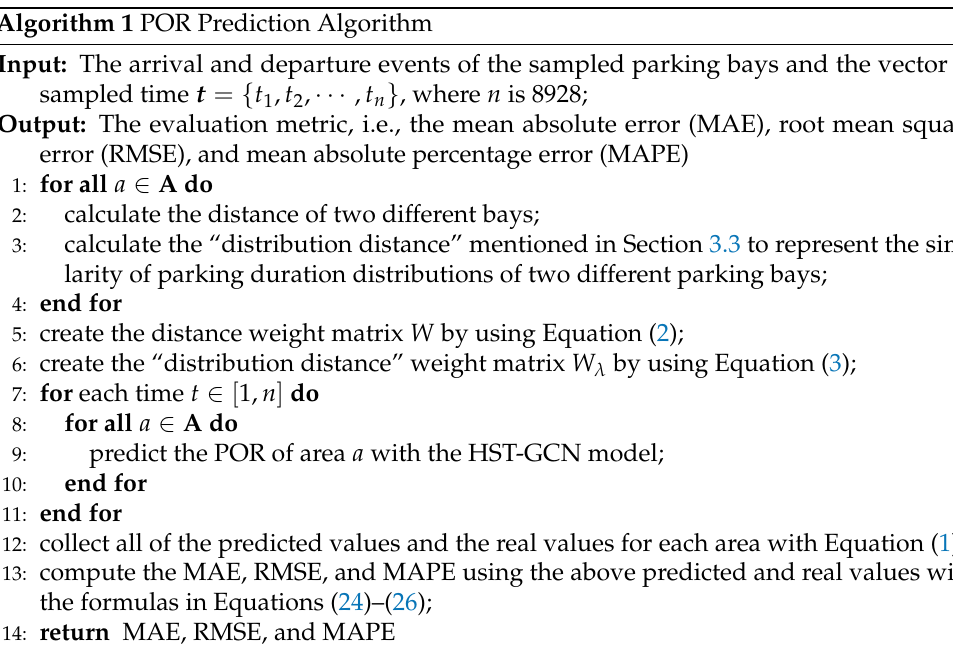
Algorithm 1 POR Prediction